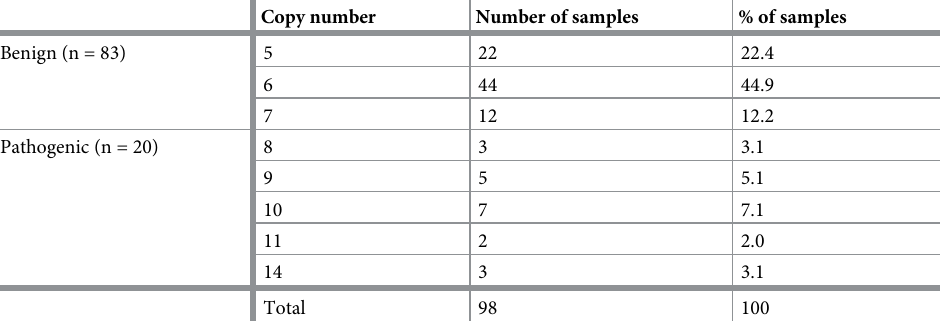
Table 1. Number and percentage of samples representing different NEB TRI CNs. The NEB TRI CN of 6 is consid- ered the normal CN, with 5 and 7 being benign CNVs. A deviation of two or more NEB TRI blocks is considered a pathogenic